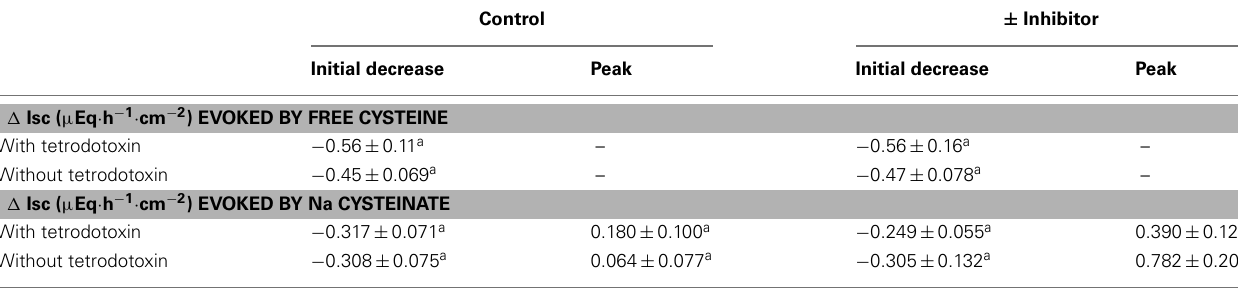
Table 5 | Effect of cysteine after neuronal